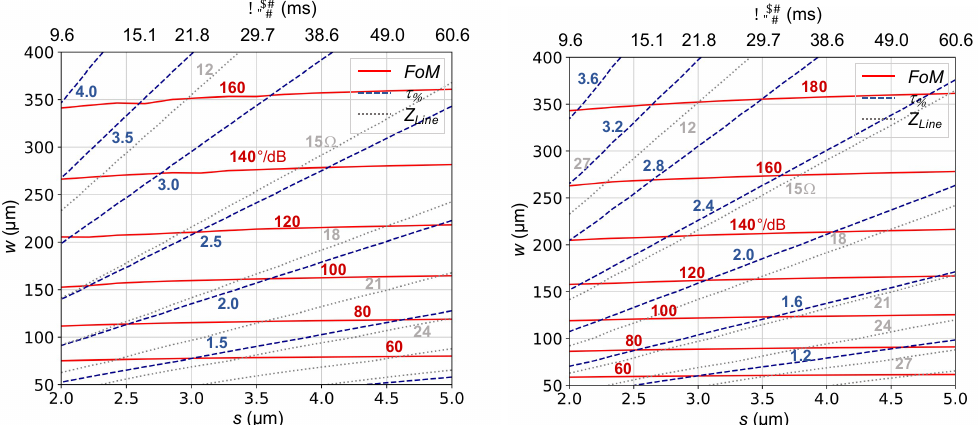
Figure 27. Plots for designing CPW loaded-line structure given in the upper right picture. The varactors are filled with second-generation LC TUD-566 ( upper left ) and third-generation LC GT7-29001 ( below ) for 30 GHz ( left ) and 60 GHz ( right ). As the top and bottom layer, use is made of fused silica with height h s = 300 µ m, relative permittivity of ε r , s = 3.82, and a dielectric loss factor of tan δ s = 5 · 10 − 5 . The electrical conductivity of the metal parts is set to σ = 4 · 10 7 S/m. A pre-orientation of the LC in the propagation direction was chosen. These plots exhibit curves of constant phase shifter figure-of-merit (FoM, full red lines), orientation e ff ectivity τ ϕ (dashed blue lines), and line impedance Z Line (dotted gray lines), depending on the strip line width w (vertical axis) and the distance s ≈ h LC (lower horizontal axis) between the metallic conductors and the decay time T 90 (upper horizontal 10 axis).